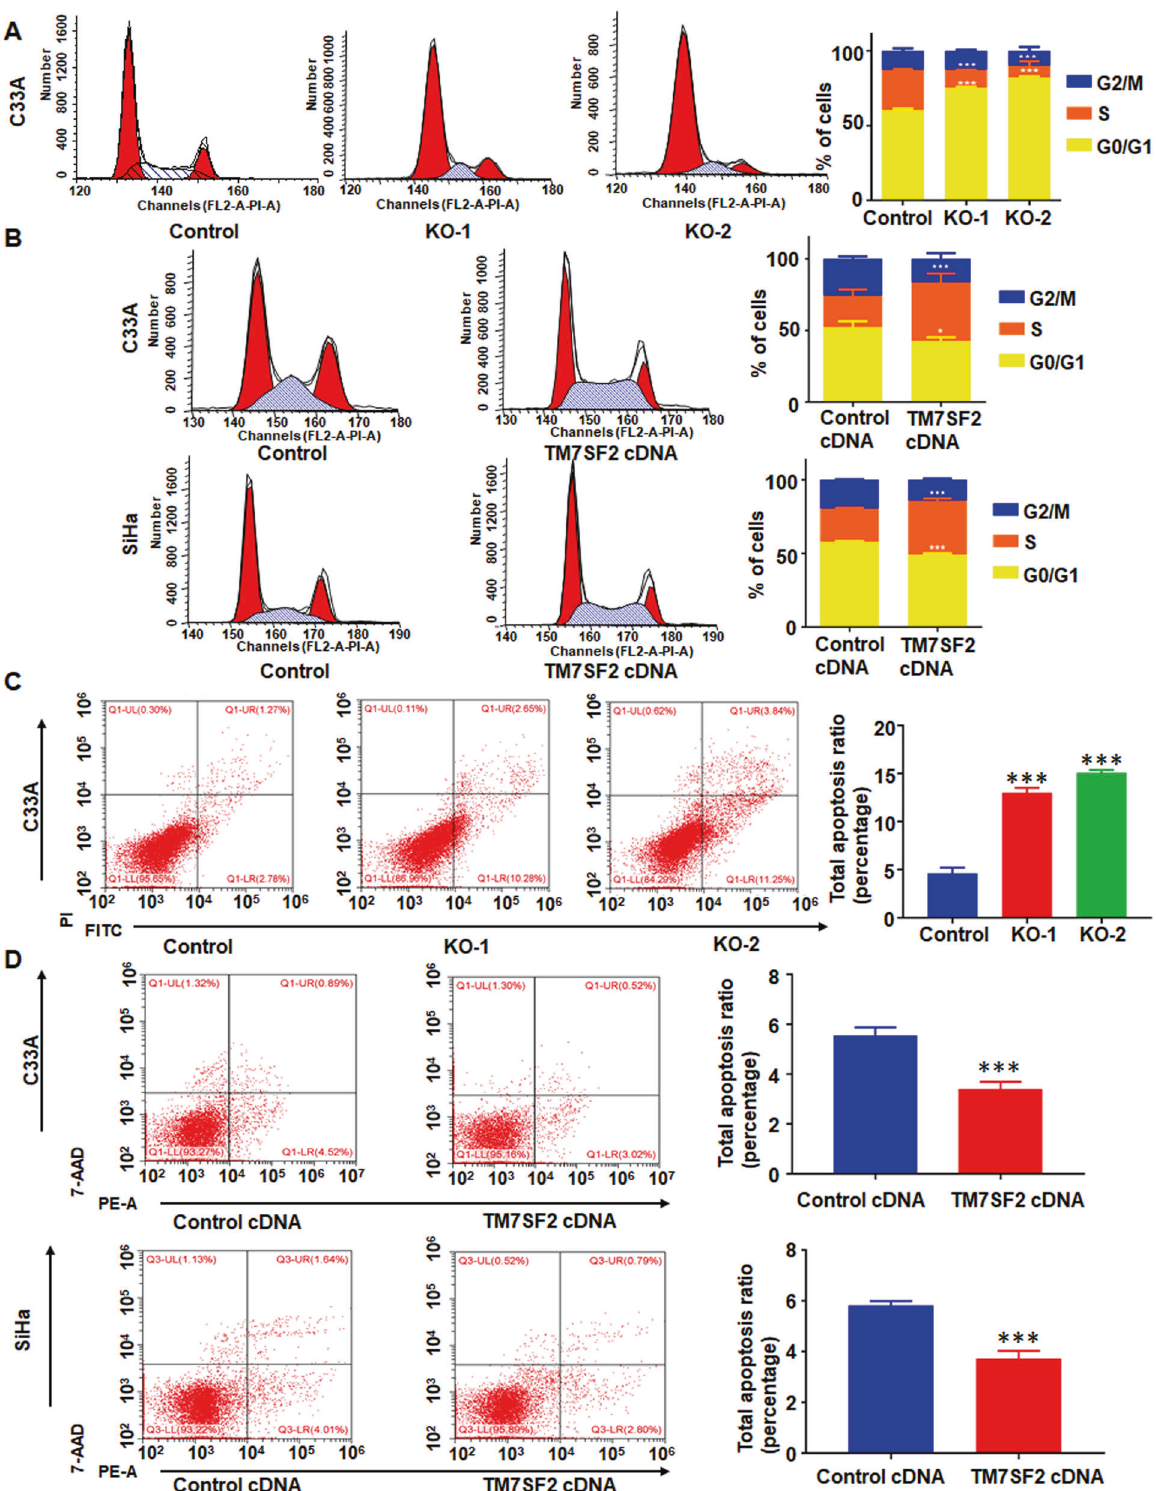
Fig. 4 TM7SF2 modulates cell cycle distribution and apoptosis in cervical cancer cells. A Left panel: the effect of TM7SF knockout on cell cycle distribution in C33A cells. Right panel: quantitative analysis for left panel. B Left panel: the effect of TM7SF overexpression on cell cycle distribution in C33A and SiHa cells. Right panel: quantitative analysis for left panel. C Left panel: the effect of TM7SF knockout on cell apoptosis in C33A cells. Right panel: quantitative analysis for left panel. *** p < 0.001 compared to control. D Left panel: the effect of TM7SF overexpression on cell apoptosis in C33A and SiHa cells. Right panel: quantitative analysis for left panel. *** p < 0.001 compared to control.